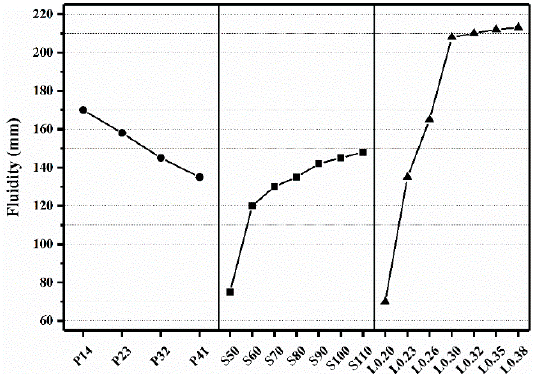
Figure 4. Effects of precursor composition, dosage of solid powdered sodium silicate and liquid–solid ratio on fl uidity of fresh paste.